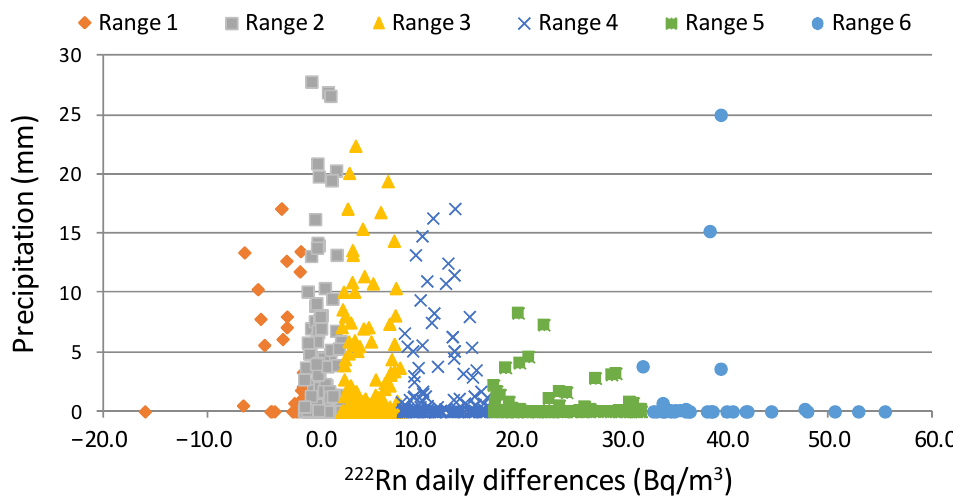
Figure 6. Scatter plot precipitation vs daily differences between maximum and background hourly 222 Rn concentrations.